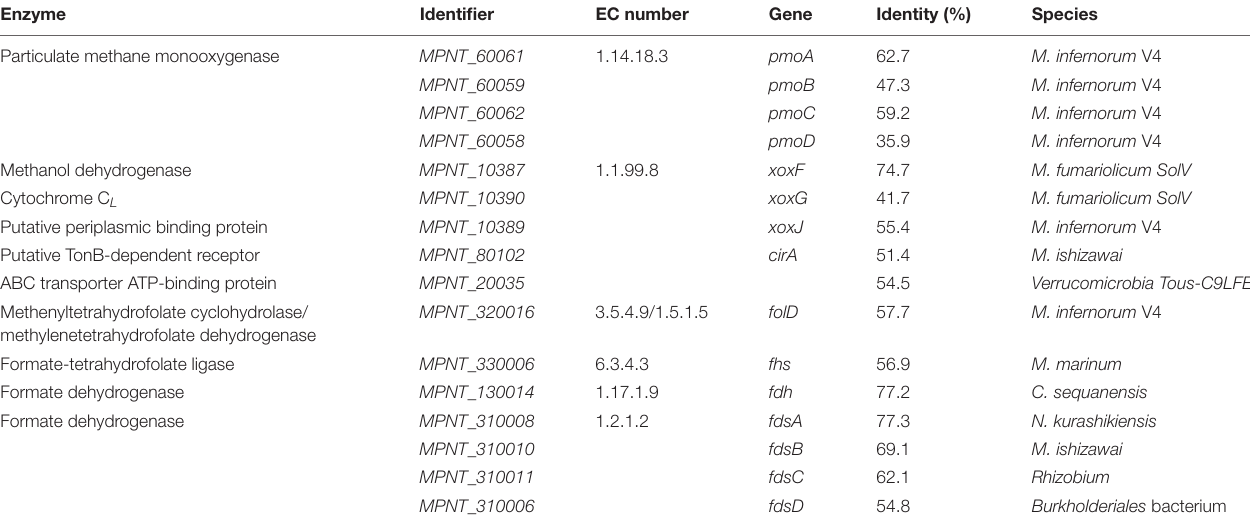
TABLE 3 | Genes encoding for enzymes involved in methane oxidation pathway, along with their Enzyme Commission (EC) numbers and percentage identity to the most similar homologue. Enzyme